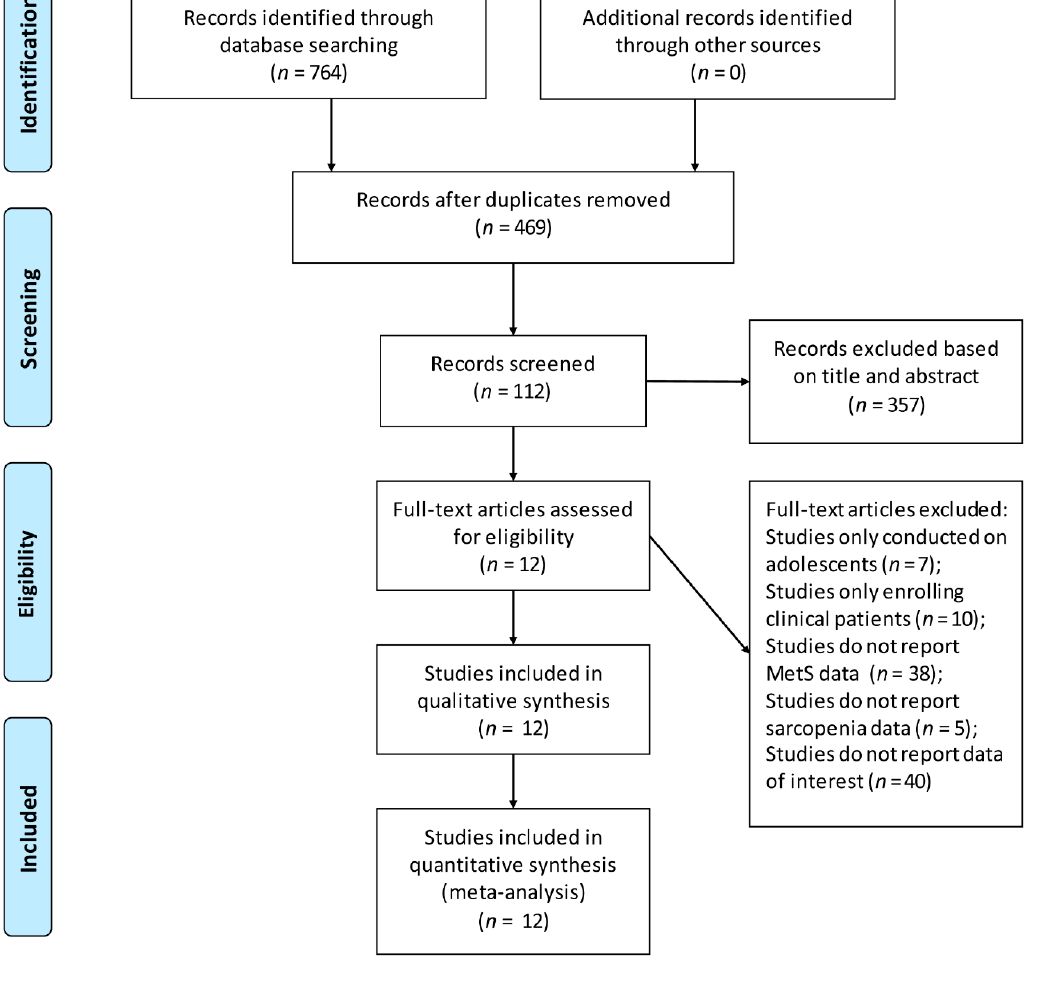
Figure 1. Flow diagram of the literature search.